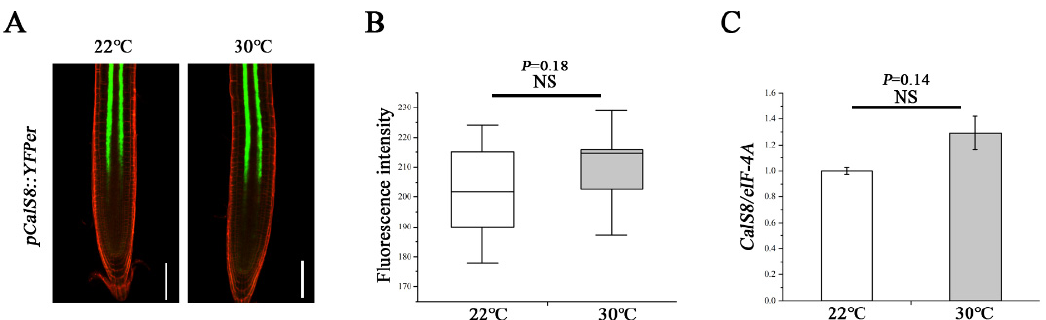
Figure 6. Transcript-level expression of CalS8 is not influenced by heat stress. ( A ) Images of pCalS8::YFPer-expressing 5-day-old seedlings roots 24 h after transfer to 22 °C and 30 °C. Scale bars = 100 µ m. ( B ) Quantification of fluorescence intensity in A using ImageJ. ( C ) Comparison of the relative transcript levels of CalS8 in the root tips of Col-0 seedlings at 24 h after being transferred to 22 °C and 30 °C. Data are based on three independent replicate experiments. Data are means ± SD. In the box plots ( B ), the boxes indicate the first and third quartiles, and the whiskers indicate the minimum and maximum values. The black lines within the boxes indicate the median values. Significant differences were determined by the two-tailed, two-sample t -test. NS, not significant.